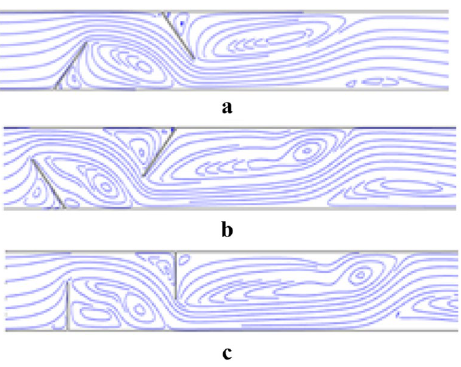
Fig. 11 Influence of inclination of baffles on the streamlines in three angles at BR = 0.6, Re = 600 (Fig. 11a: θ = 135°, Fig. 11b:θ = 45°, Fig. 11c = 90°)